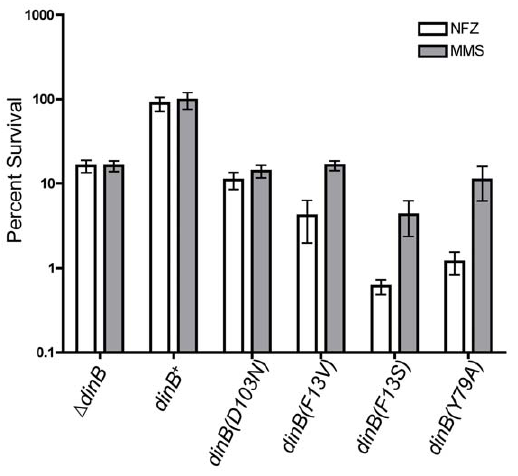
Figure 4. An aromatic triad in the DinB active site is required for D dinB survival upon treatment with MMS or NFZ. D dinB harboring the dinB alleles with mutations at position 12, 13, and 79 were treated with MMS (7.5 mM; gray bars) or NFZ (0.008 mM; white bars). Treatments were carried out as described in materials and methods. Error bars represent the standard deviation of the mean from at least 3 independent experiments. Only top error bars are shown for